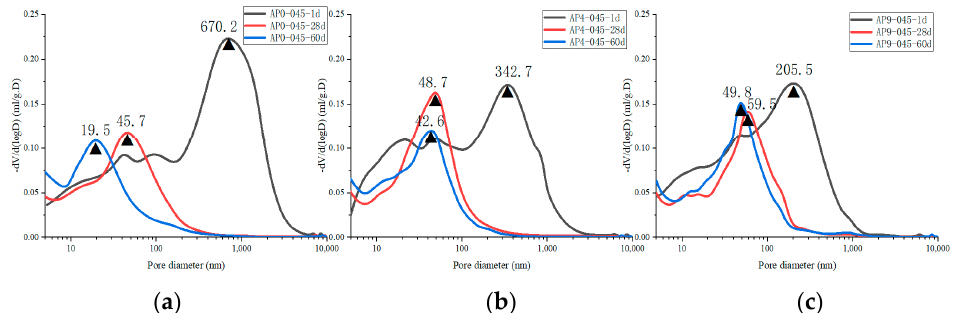
Figure 13. The pore size distribution of hydrated cement pastes with different dosages of the AS accelerator: ( a ) PA0-045; ( b ) PA4-045; ( c ) PA9-045.